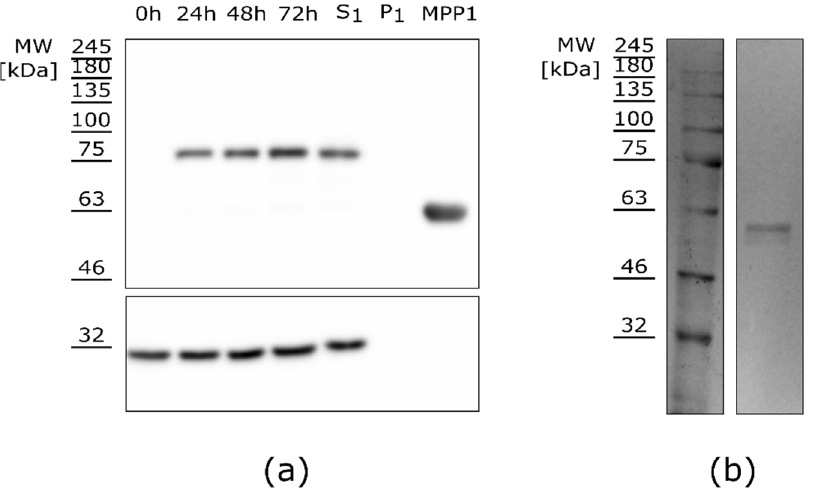
Figure 2. Expression and purification of MPP1 protein from HEK-293F cells. Western blot analysis of ( a ) crude cell lysates collected through transfection (0 h–72 h), samples collected after centrifu- gation (S1, P1) and purified recombinant protein (2 µg). The upper membrane was incubated with